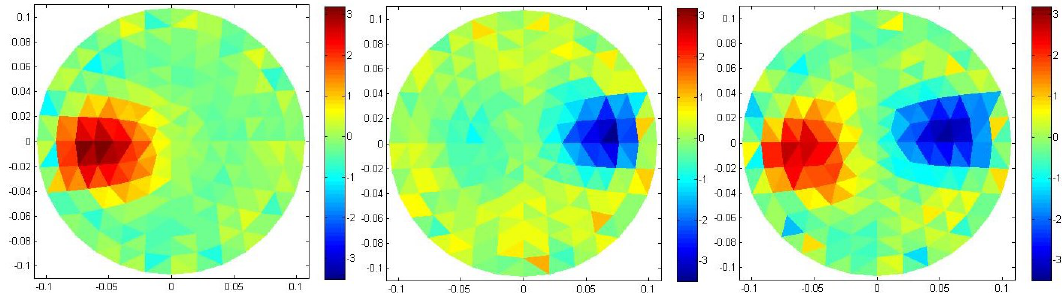
Figure 9: Reconstruction image of the relative method in uniform elements model